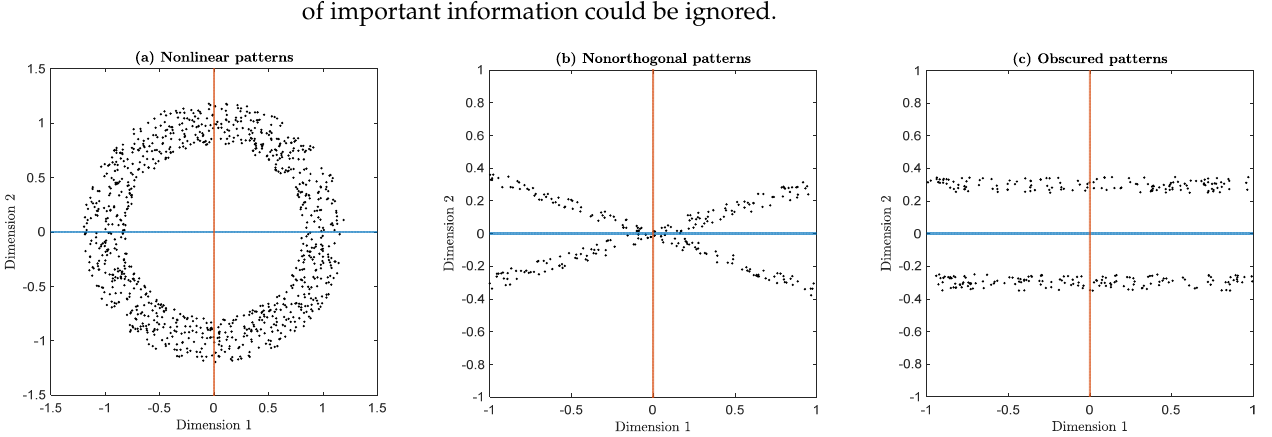
Figure 2. Limitations of PCA: missing ( a ) nonlinear pattern, ( b ) nonorthogonal patterns and ( c ) ob- scured clusters. PC1 and PC2 are shown in blue and orange, respectively.